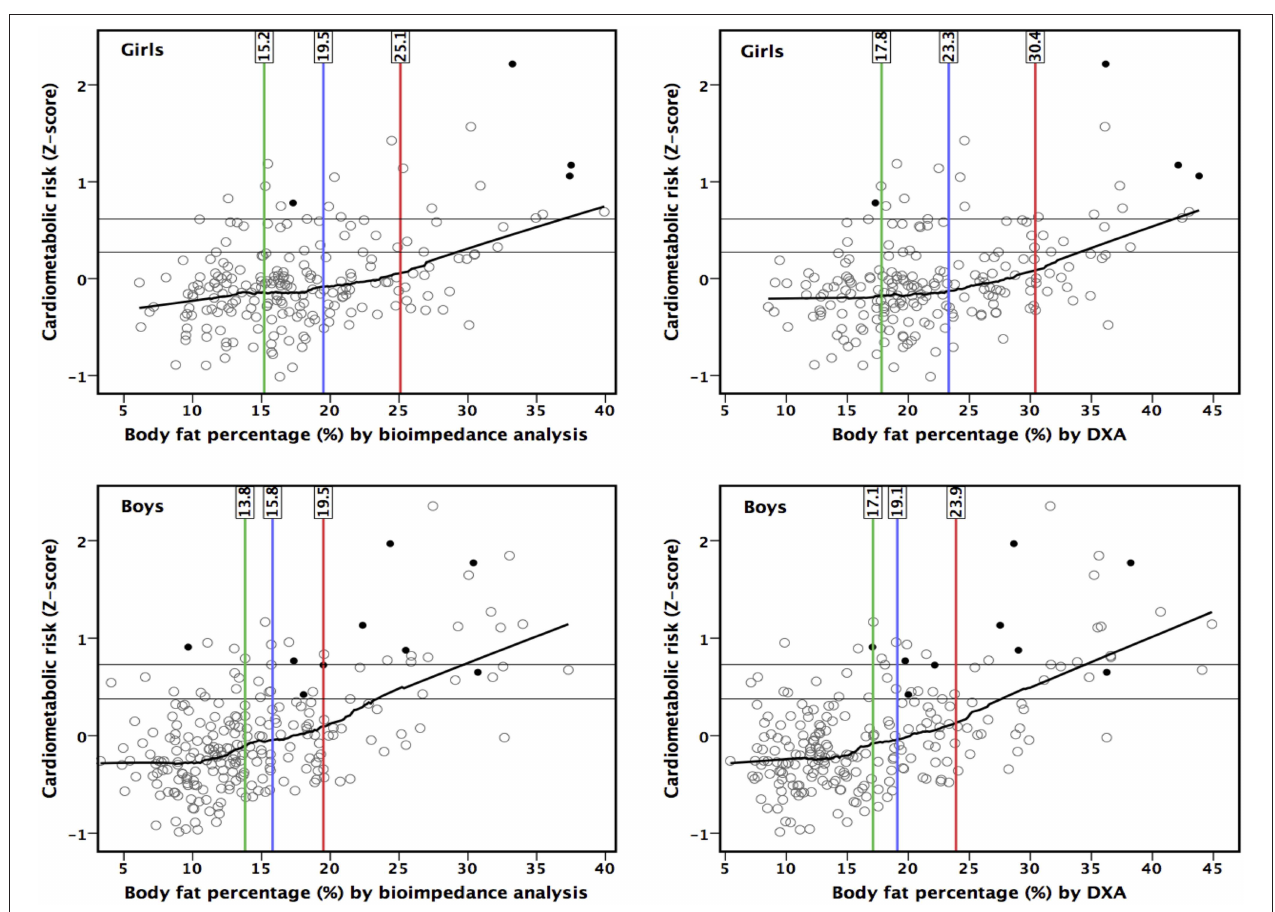
FIGURE 3 | Associations of body fat percentage by bioimpedance analysis and by dual-energy X-ray absorptiometry (DXA) with cardiometabolic risk score (components were serum insulin and plasma high-density lipoprotein cholesterol, triglycerides, gamma-glutamyl transferase, high-sensitivity C-reactive protein and uric acid). Black dots represent children with metabolic syndrome ( 33). Horizontal lines describe the 80 and 90th percentiles for cardiometabolic risk score. Vertical lines represents the thresholds by negative likelihood ratio ( < 0.20) (green line), the point where sensitivity equals with specificity (blue line), and positive likelihood ratio ( > 5) (red